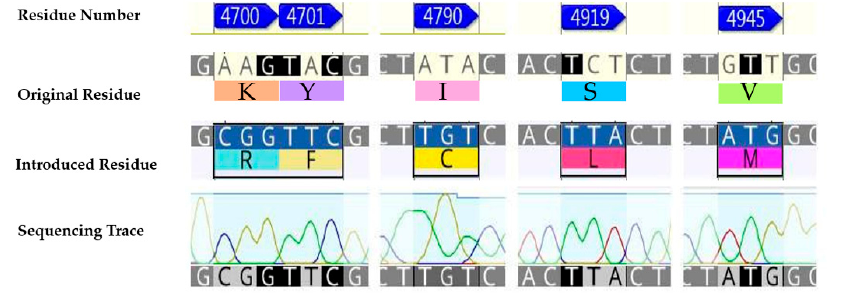
Figure 2. The five aa residue changes investigated: K4700R; Y4701F; I4790C; S4919L; V4945M.